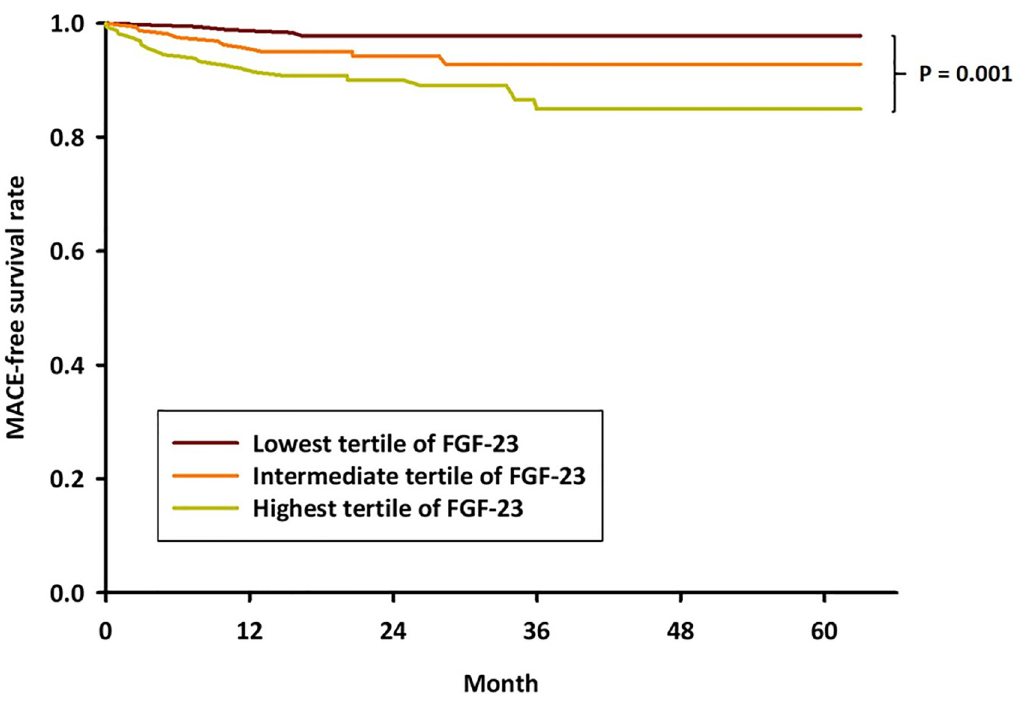
Fig 2. Kaplan–Meier survival curves stratified by baseline FGF-23 levels. The MACE-free survival rate was significantly reduced in patients with high FGF-23 levels ( P = 0.001 by log-rank test).